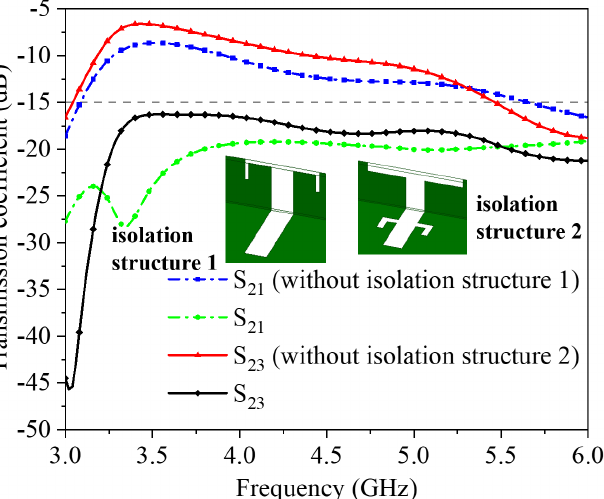
Figure 5. The simulated transmission coefficients of the designed antenna with/without isolation structure.